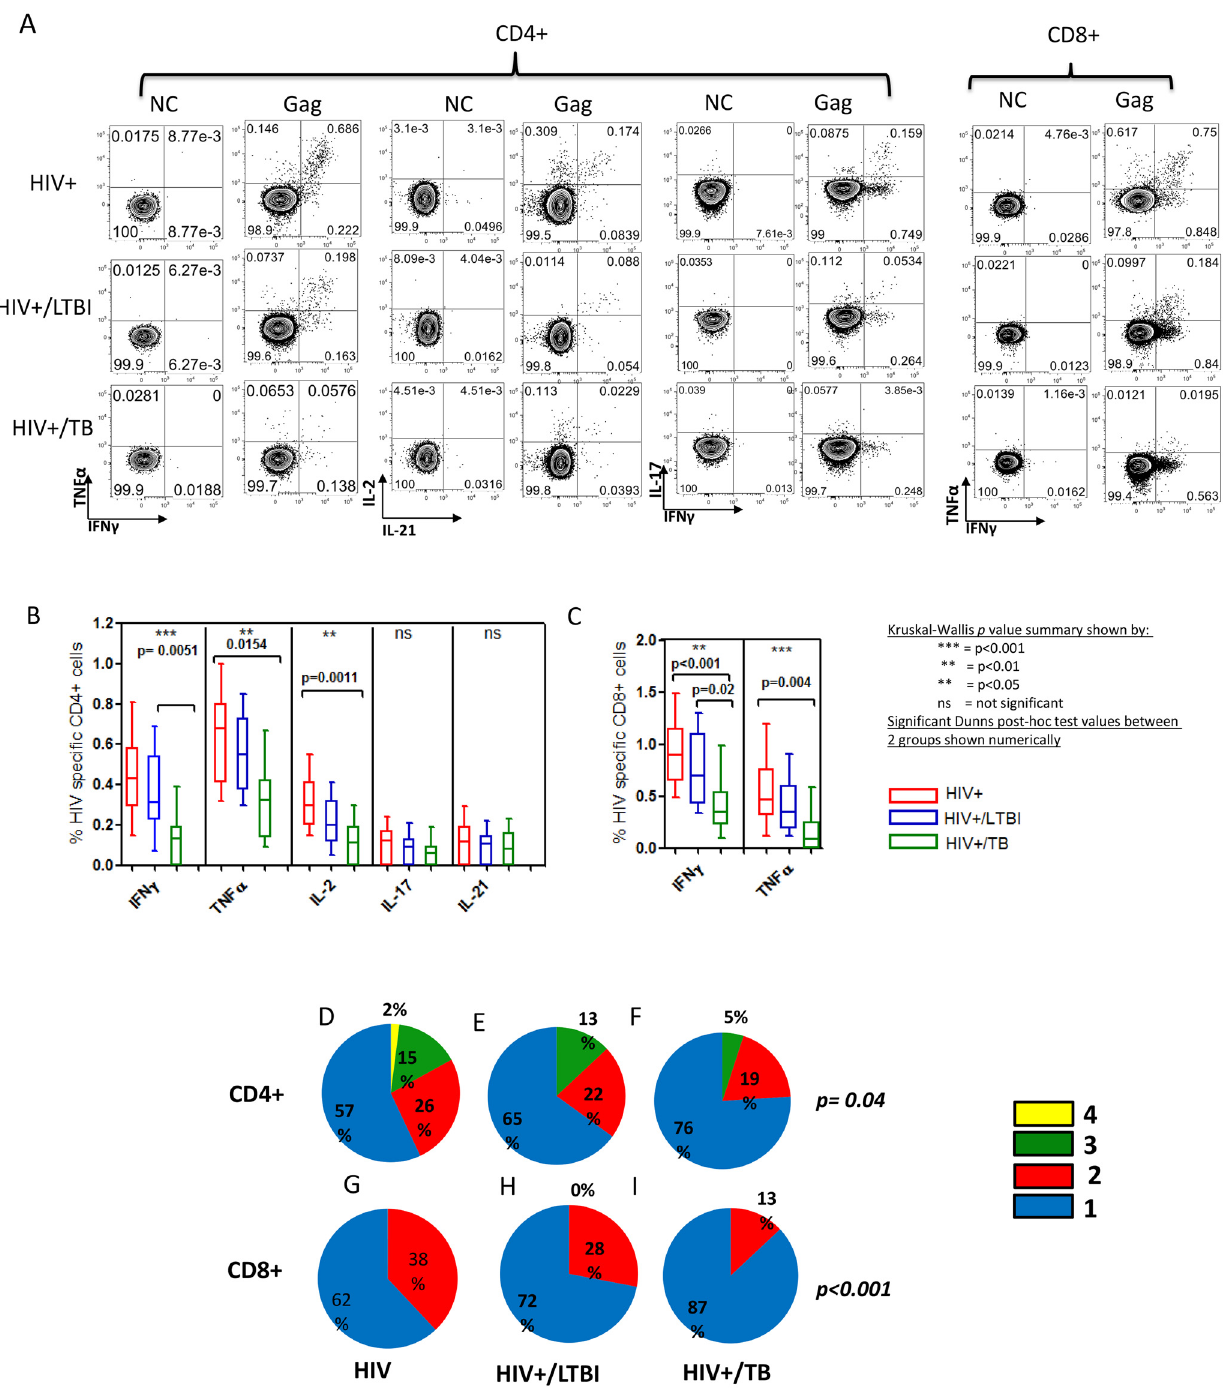
Fig 1. HIV specific CD4+ and CD8+ T cell functionality is reduced in HIV infected individuals co-infected with latent Mycobacterium tuberculosis infection (LTBI) and active Tuberculosis (TB) disease. (A) Representative flow cytometry plots showing cytokine responses for HIV (gag), control (no antigen) for HIV mono-infected subjects, and subjects co-infected with latent MTB infection (LTBI) and active tuberculosis (TB) (B) HIV-specific CD4+ release of IFN γ (p < 0.001), TNF α (p < 0.01) and IL-2 (p < 0.01) were significantly different between all groups (Kruskal-Wallis). (C) HIV-specific CD8+ release of IFN γ (p < 0.01) and TNF α (p < 0.001) was significantly lower from HIV mono-infected subjects, to those co-infected with active TB. We additionally assessed the polyfunctionality profile of HIV specific CD4+ and CD8+ T cells in all patient groups. The polyfunctionality profiles between groups differed significantly for both CD4+ (p = 0.04) and CD8+ (p < 0.001). (D) HIV-specific CD4+ T cells from HIV mono-infected subjects displayed a polyfunctional CD4+ T cell profile with a maximum of four functions being present (IFN + IL-2 + IL-17 + TNF α (2%)). (E) HIV-specific four function CD4+ T cells were not present in